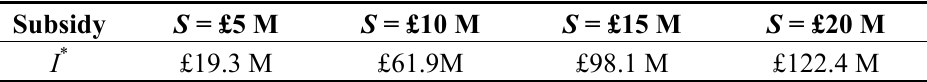
Table 15. Trigger cost I * as a function of a one-time subsidy